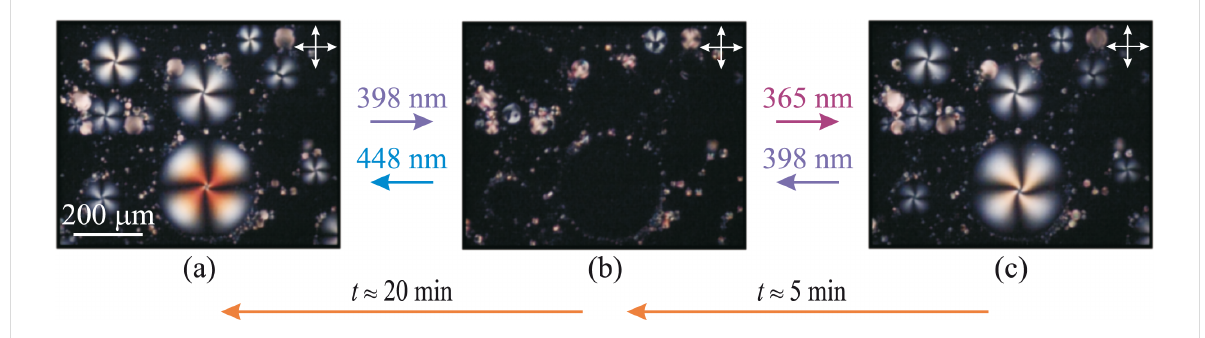
Figure 3: POM images of NLC droplet structures in contact with the solid substrate obtained under light-emitting diode irradiation with wavelengths of (a) 448 nm, (b) 398 nm and (c) 365 nm. The arrows show the direction of transitions. The double arrows show the directions of the crossed polarizers.